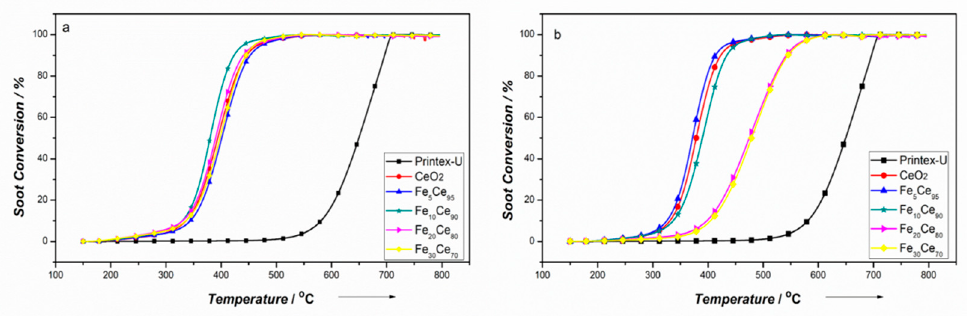
Figure 8. Soot conversion of tight contact condition: ( a ) Co-precipitation method, ( b ) solution combustion synthesis method.